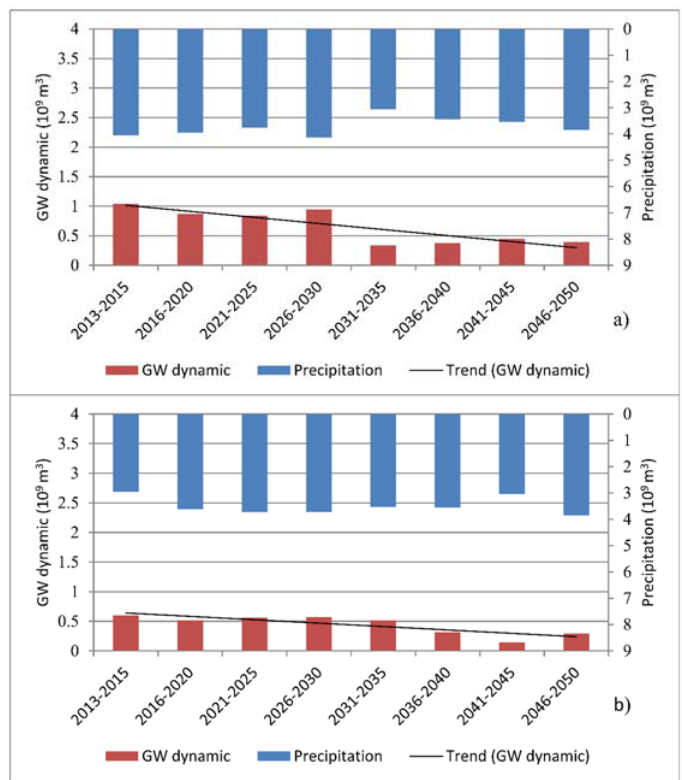
Figure 9. Comparison between precipitation and groundwater dynamic (groundwater recharge + groundwater outflow) in billion cubic meters (10 9 m³) in the Klela basin for the climate scenarios ( a ) RCP4.5 and ( b ) RCP8.5. The lines are linear regressions of trends in groundwater dynamic against time.